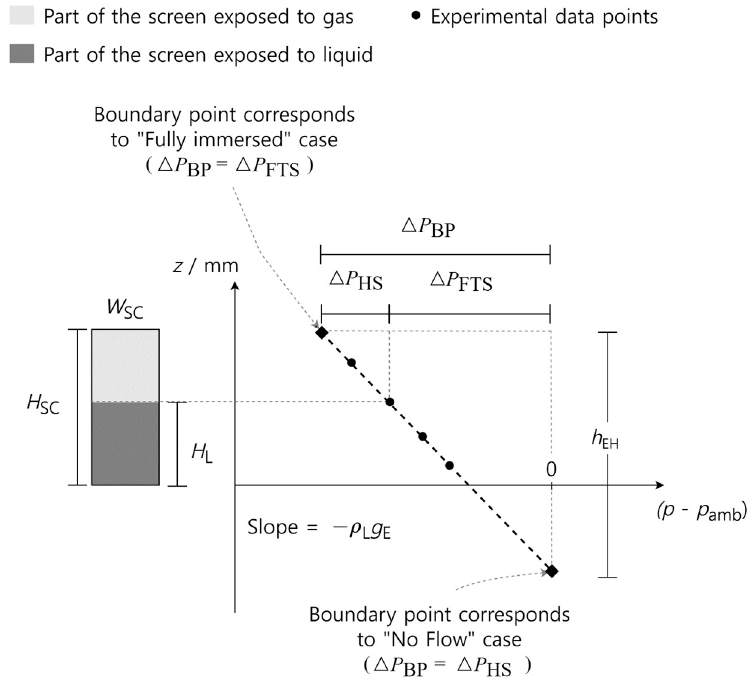
Figure 4. Schematic diagram of the graphical representation of results from the gas − liquid phase- separation